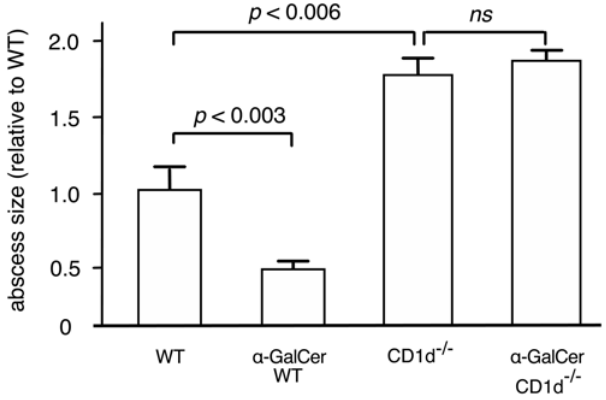
Figure 1. Role of NKT cells in the control of ALA in mice. Mice treated with a -GalCer or mice lacking CD1d (CD1d 2 / 2 ) were intrahepatically infected with virulent E. histolytica trophozoites. Seven days p.i. animals were sacrificed and sizes of liver abscesses determined. Bars represent sizes of abscess scores relative to those of wildtype control mice (WT). Results were obtained from 3 independent experiments comprising 5 to 7 animals each (statistics: Mann-Whitney U